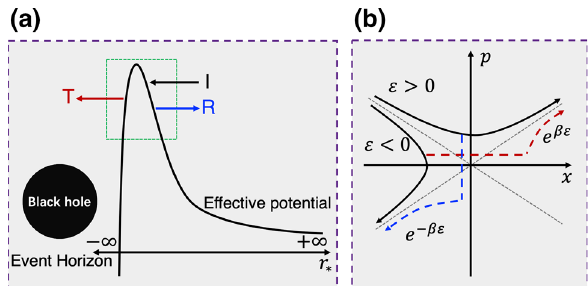
Fig. 1 a Scattering off an effective potential approximately equal to an inverse harmonic potential, outside a black hole, where r ∗ is the “tor- toise coordinate”, and the event horizon is located at r ∗ → −∞ . Blue and red arrows schematically denote reflection (R) and transmission (T) processes,andtheblackarrow denotestheincoming(I)particlecurrent. b Scattering via the inverse harmonic potential leads to classical trajec- tories of incoming particles (solid lines) and particle tunneling (broken lines) near the hyperbolic fixed point ( x , p ) = ( 0 , 0 ) in phase space. The dotted lines are the separatrices (ε = 0 ) , and β = 1 / T . Note here that the direction of the incoming particle for the IHO case in ( b ) is chosen to be consistent with Ref. [39], and is opposite for the black hole case in ( a ). However, these two cases share effectively the same essential physics, as discussed in the text at the end of Sect. 2.1 and